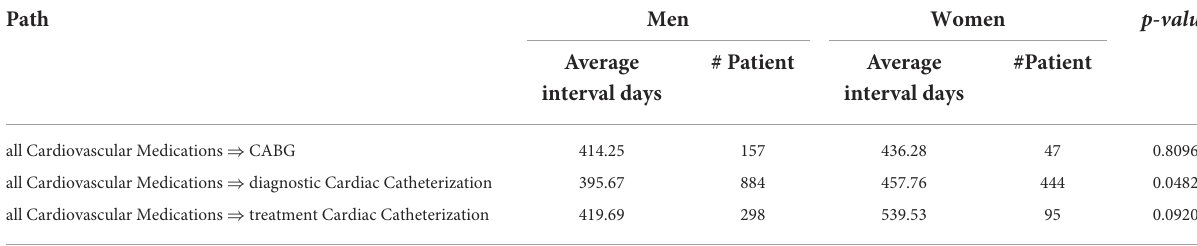
TABLE 5 Example of gender-based data analytics for all cardiovascular related medications as starting point of the treatment plan.